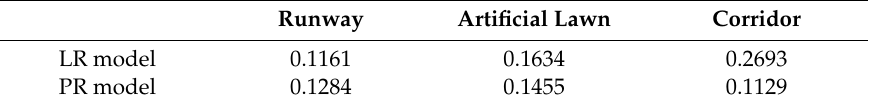
Table 4. RMSEs of RSSI based link quality estimators (LQEs) in di ff erent